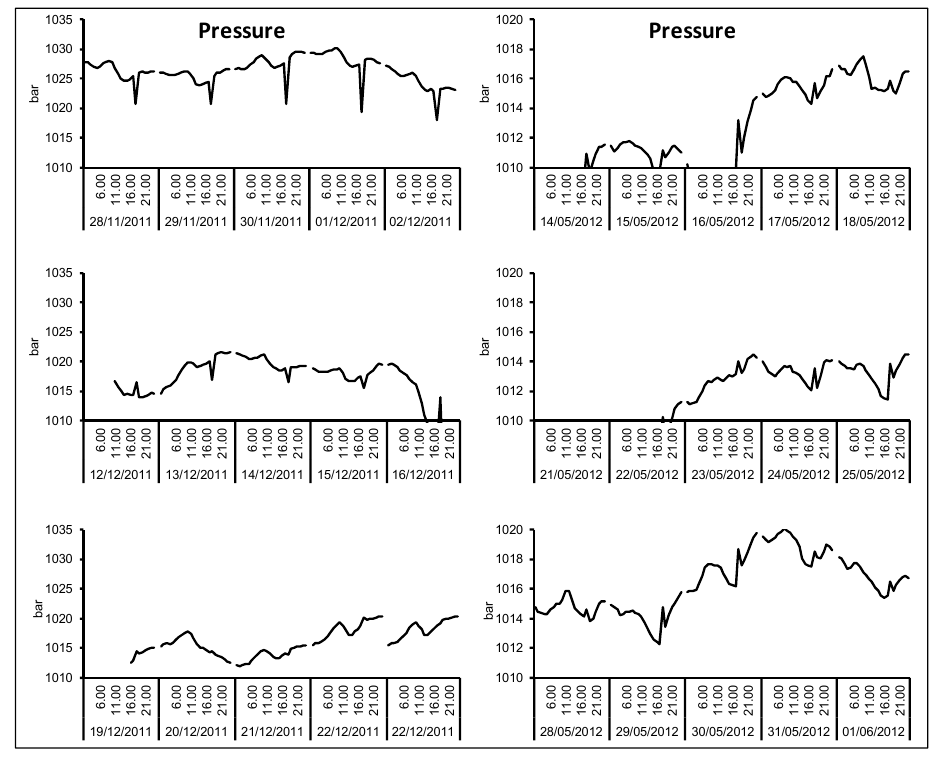
Figure A2. Time pattern of atmospheric pressure during the winter and spring/summer campaigns.